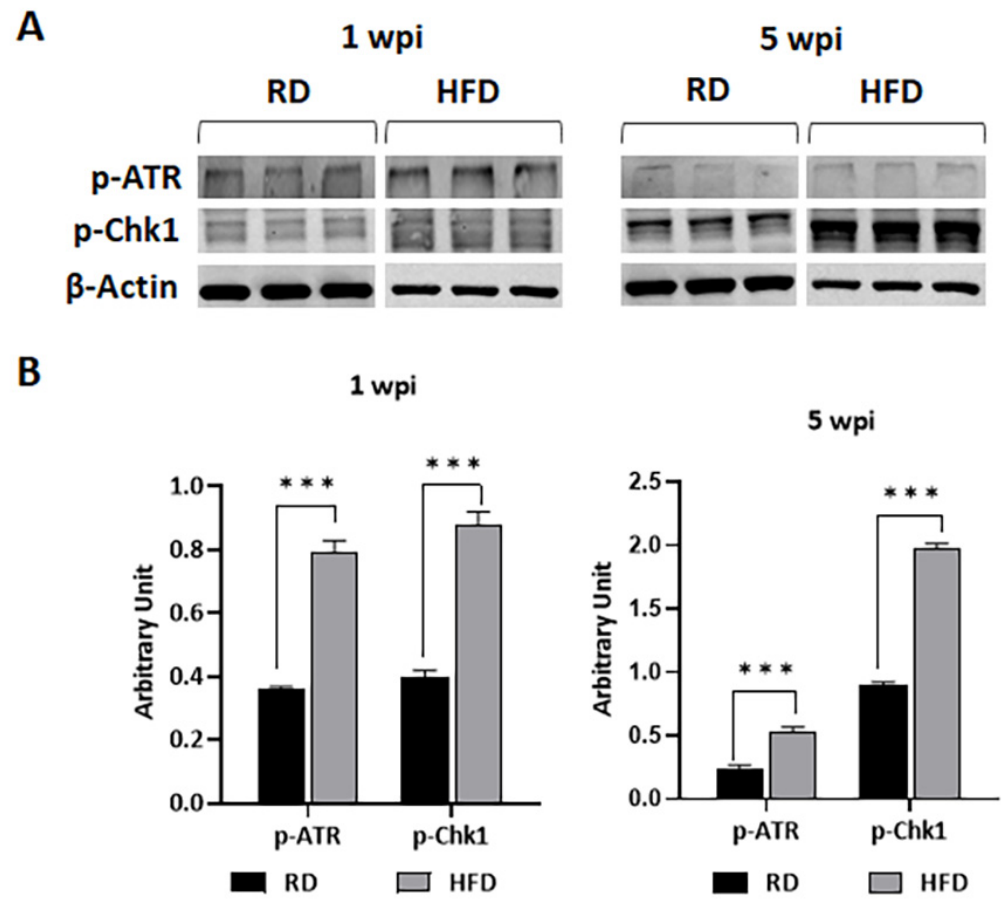
Figure 8. RD and HFD differently regulate the markers of DNA damage (p-ATR and p-Chk1) in tumor-associated mammary fat pads during early (1 wpi) and later (5 wpi) time points of tumor growth in young female E0771 tumor-bearing mice. ( A ) Immunoblots showing different protein expression levels between RD and HFD at 1 wpi and 5 wpi. β -Actin was used as loading control. ( B ) Bar graphs showing the levels of each protein marker normalized to β -Actin ( left panel—1 wpi; right panel—5 wpi). The error bars represent the standard error of the mean. *** p ≤ 0.001.